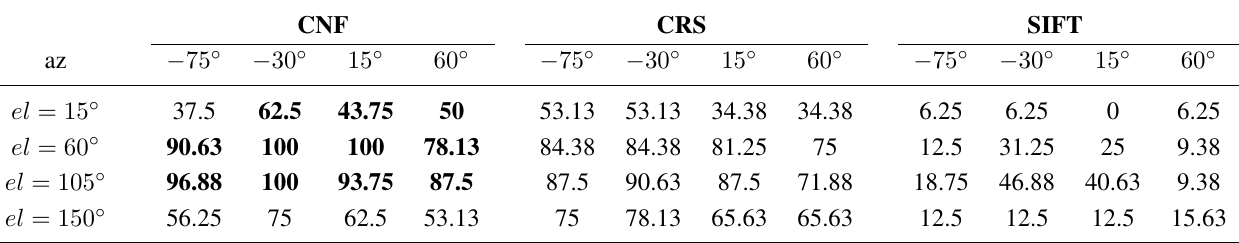
Table 2. Recognition rates on the query set when α = 1 . 0 and β = 0 . 5 . CRS SIFT